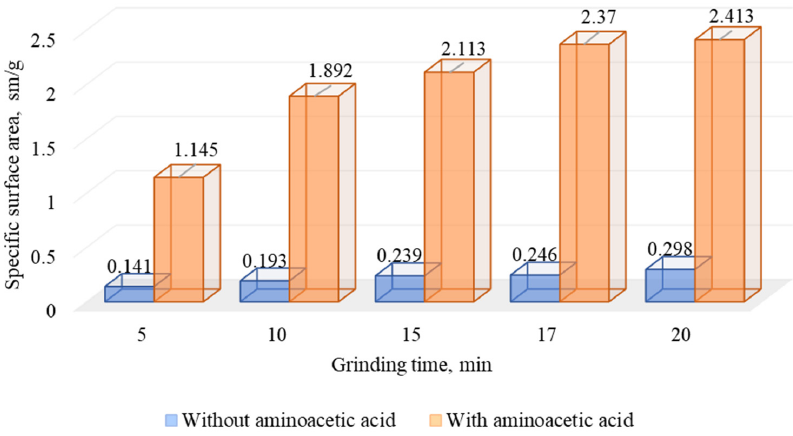
Figure 15. Results of research on changes in the specific surface area of DOS during comminution without and with aminoacetic acid.